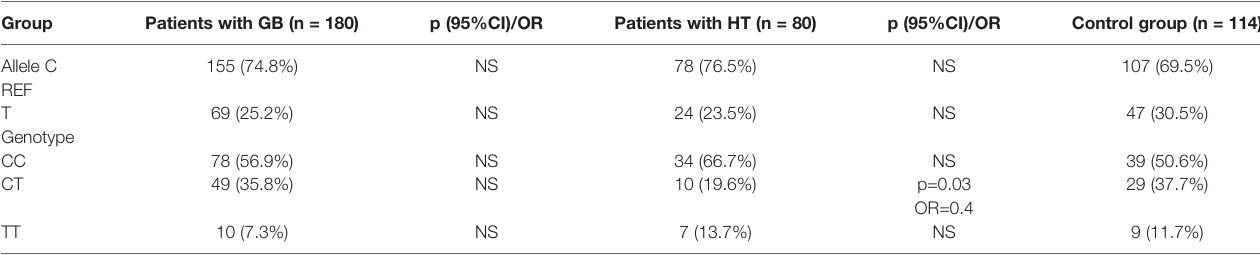
TABLE 4 | Genotype and allele frequencies for PADI4 gene polymorphism (rs1748033) in groups with Graves ’ disease (GD) and with Hashimoto ’ s thyroiditis (HT) compared to control group. Group Patients with GB (n = 180) p (95%CI)/OR